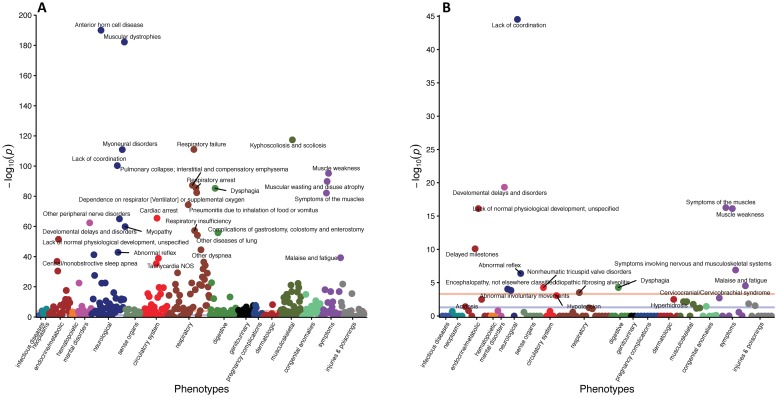
Manhattan plots of phenotypes with increased prevalence in SMA for Group A.(A) Phenotypes with increased prevalence in SMA patients compared to controls throughout their entire coverage window. Only selected phenotypes with p-value<4e-25 are displayed. (B) Phenotypes with increased prevalence in SMA patients compared to controls from only data prior to the first sign of neuromuscular degeneration. Only phenotypes with p-value<0.05 are displayed. For both plots, the purple line represents an adjusted p-value of 5x10(-2) and the peach line represents an adjusted p-value of 5x10(-4). Completes lists of phenotypes are presented in the supplemental tables.